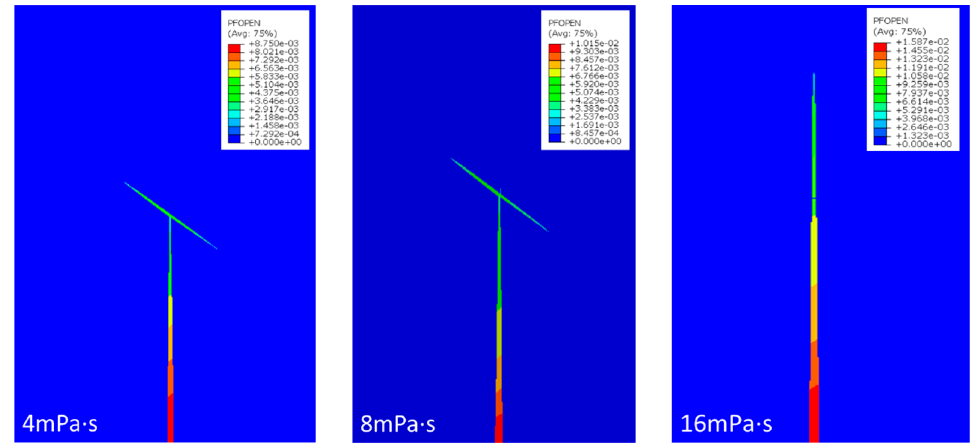
Figure 9. Crack geometry in different fracturing fluid injection viscosity.